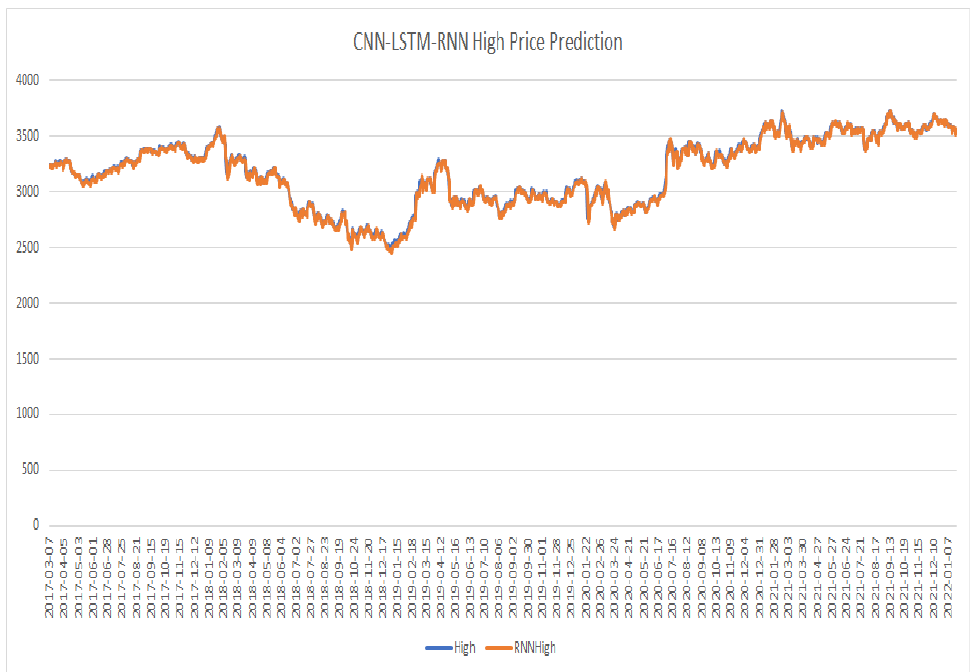
Figure 19. CNN-LSTM-RNN model high price